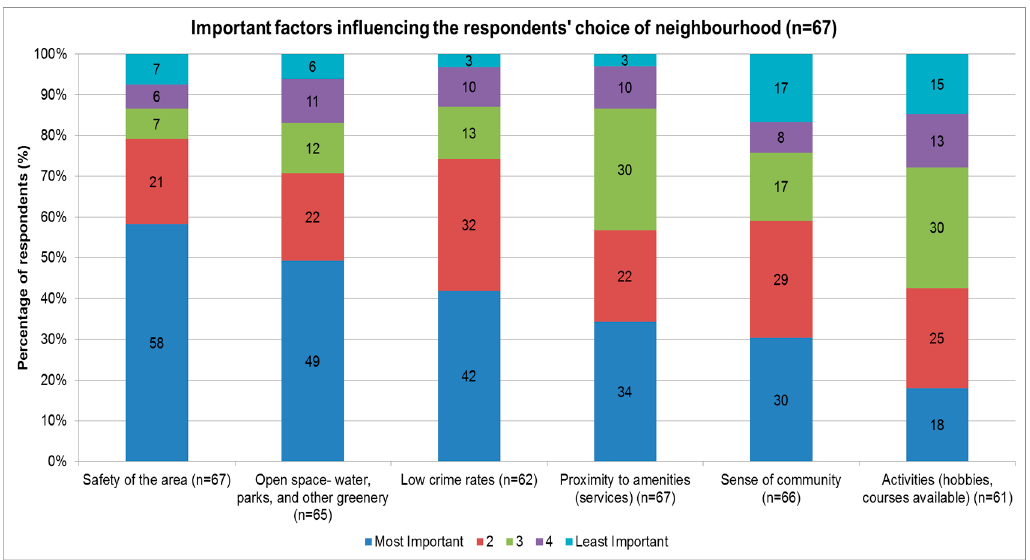
Figure 5. Which factors are important when choosing a neighbourhood (families—single parents and co ‐ habiting).